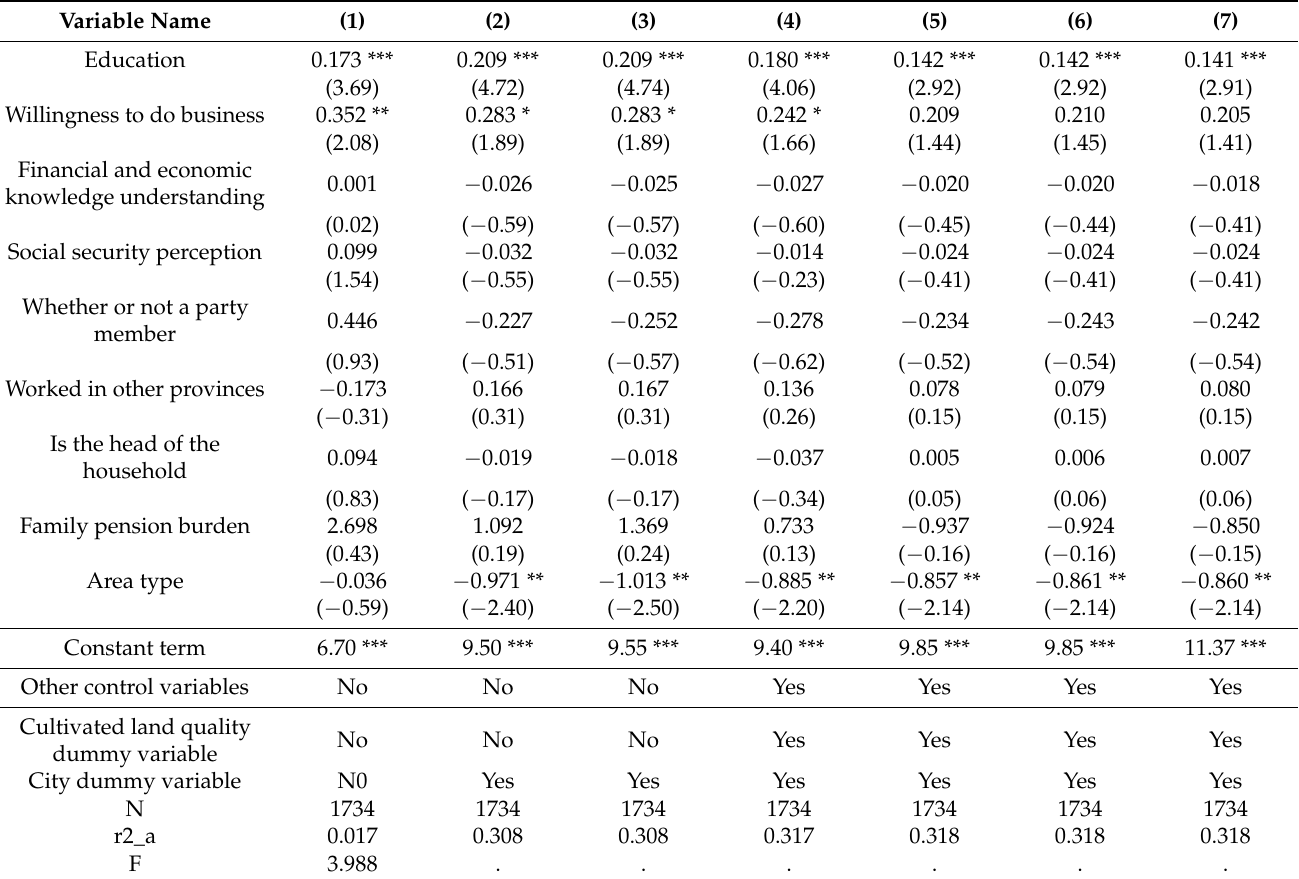
Table 5. Heterogeneity analysis: individual characteristics, family characteristics and regional